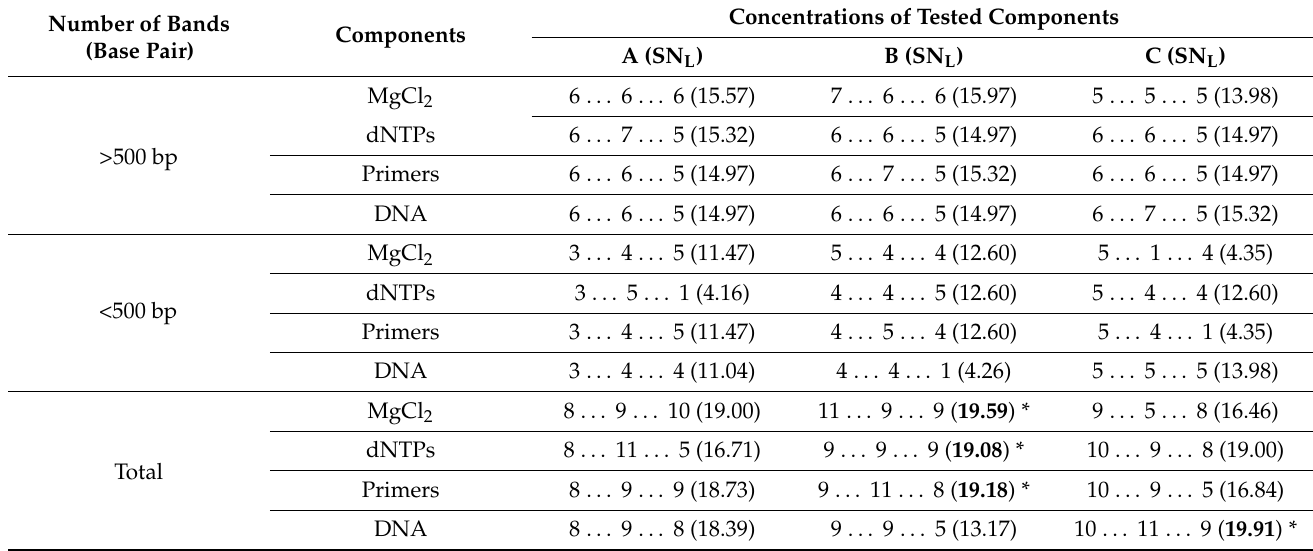
Table 2. SN L ratios for a set of RP2 and 1247 primers used for C. parapsilosis fingerprinting.